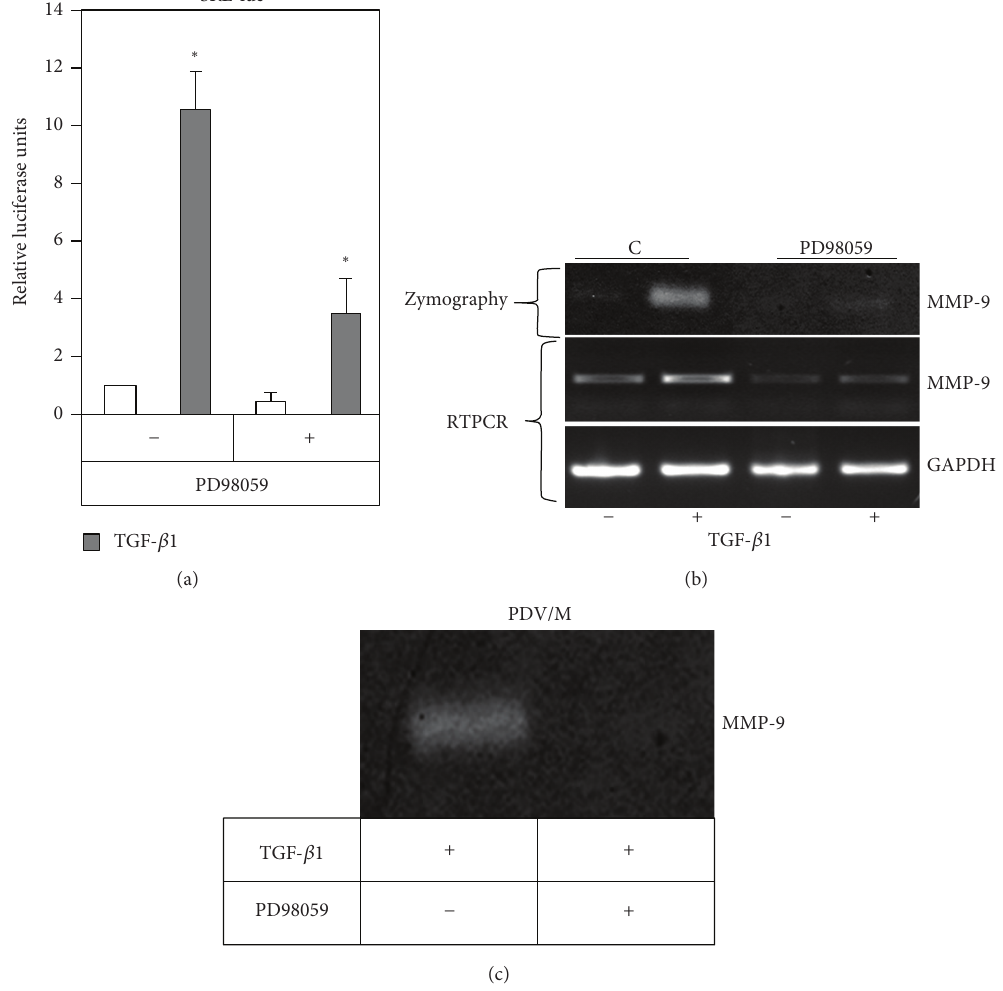
F 5: e enhancement of ERK1,2-dependent signaling mediates the TGF- (a) Inhibition of transcriptional activity of ERK1,2-dependent SRE-Luc reporter by PD98059 (25 assay and RT-PCR analysis in AS-S cotreated with the MEK1,2 inhibitor PD98059 and/or TGF- and 24h for RT-PCR. GAPDH was ampli�ed as RT-PCR control for the amount of cD�A present in each sample. (c) Gelatine-zymography assay of PDV/Mock control cells treated 48h with TGF-